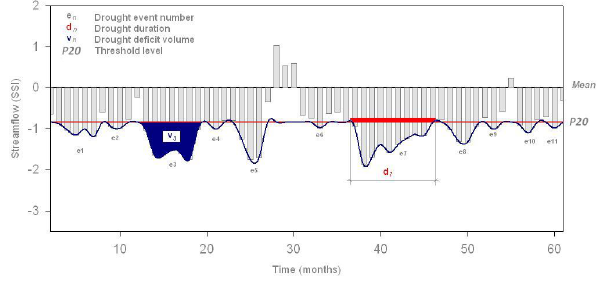
Fig. 2. Drought definition